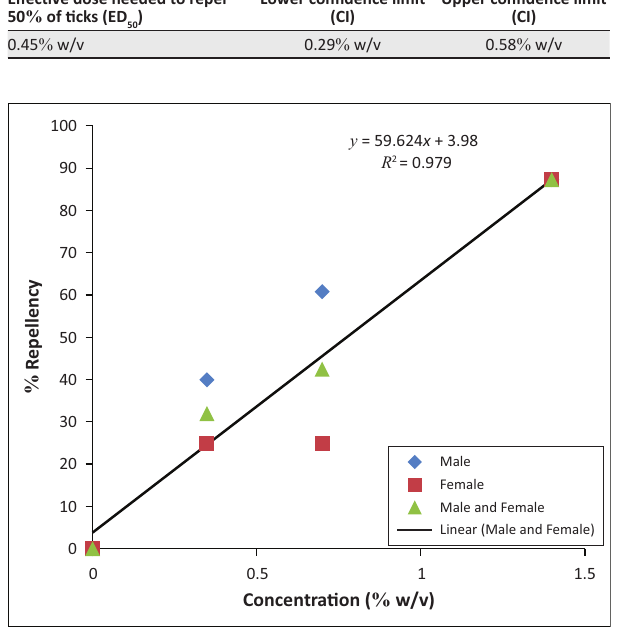
TABLE 1: Effective dose needed to repel 50 % of ticks in the Type A repellency bioassay following exposure of adults Hyalomma rufipes ticks to dichloromethane extracts of Allium sativum at concentrations of 0.35 % , 0.7 % and 1.4 % w/v. Effective dose needed to repel 50 % of ticks (ED ) 50